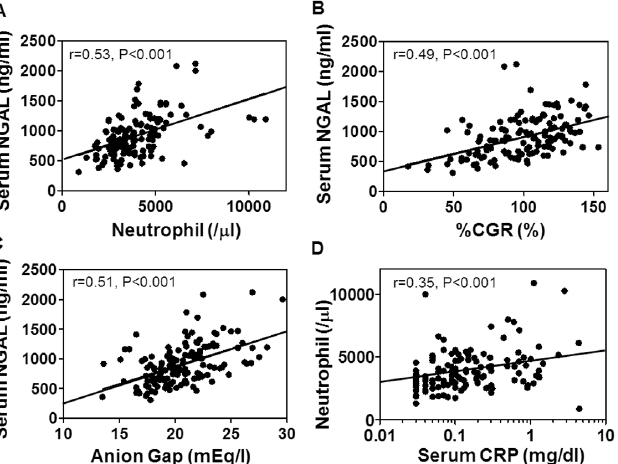
Fig 1. Linear correlation of baseline pre-dialysis serum NGAL levels with clinical parameters. Correlations of serum NGAL level with ( A ) peripheral blood neutrophil count, ( B ) % creatinine generation rate (%CGR) and ( C ) anion gap are shown. ( D ) Correlation between neutrophil count and serum C-reactive protein (CRP) level is also shown. Linear line in each graph shows regression line. N = 139.